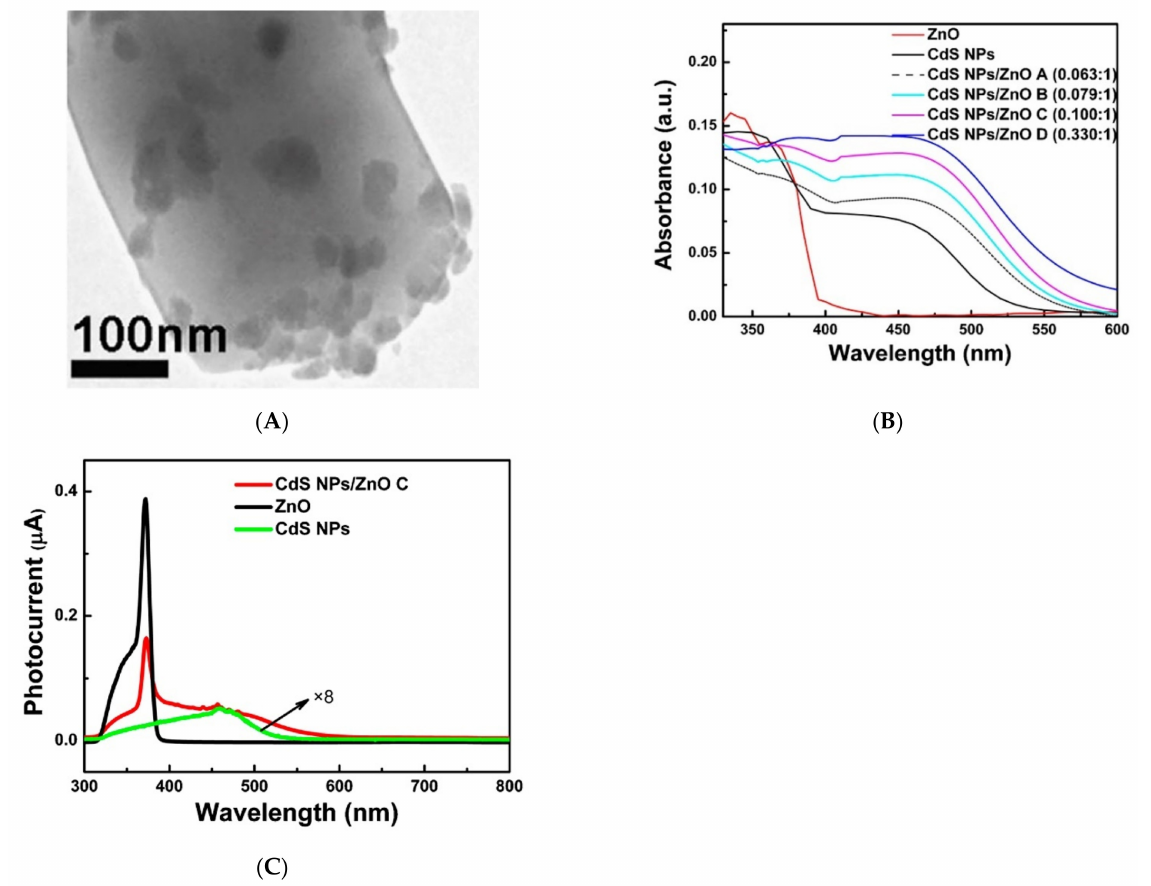
Figure 8. ( A ) Electron microscopy image of ZnO/CdS nanocomposite; ( B ) Absorbance spectra of ZnO, CdS nanoparticles, and ZnO/CdS nanocomposites; ( C ) photocurrent spectra of ZnO, CdS nanoparticles, and ZnO/CdS nanocomposites. Reprinted from [148] with permission from Elsevier,